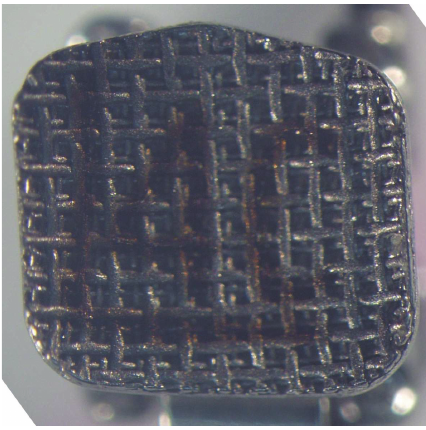
Figure 3: In-Ovation R bracket, double layer.